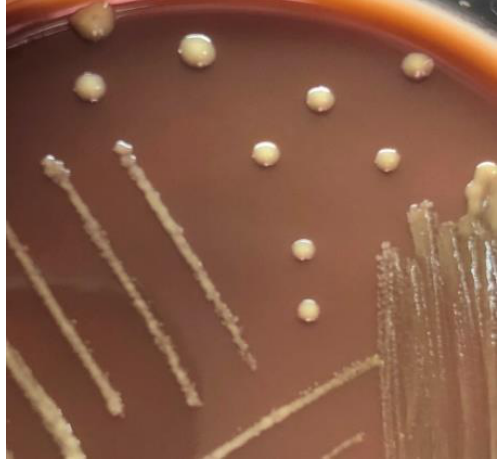
Fig. 6: Lactobacilli colonies on MRS blood agar plates showing γ –hemolysis.